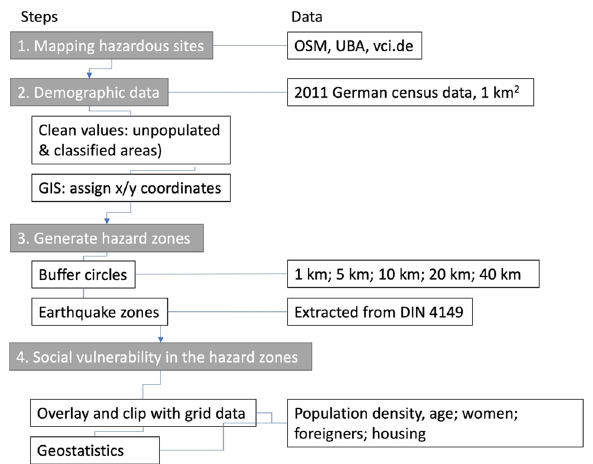
Fig. 1 Methodological steps of the assessment of spatial industrial accident exposure and social vulnerability in Germany. OSM Open- StreetMap, UBA Umweltbundesamt / German Environment Agency, VCI Verband der Chemischen Industrie / Chemical Industry Associa- tion,